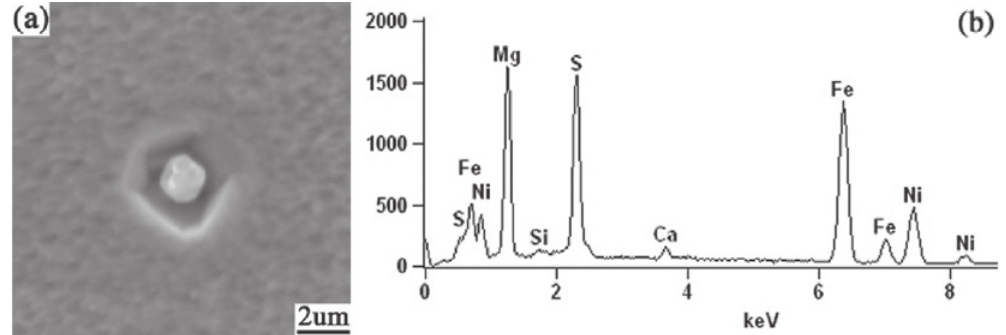
Fig. 6: SEM morphology and EDS analysis of the typical MgS particle. (a) SEM morphology; (b) EDS